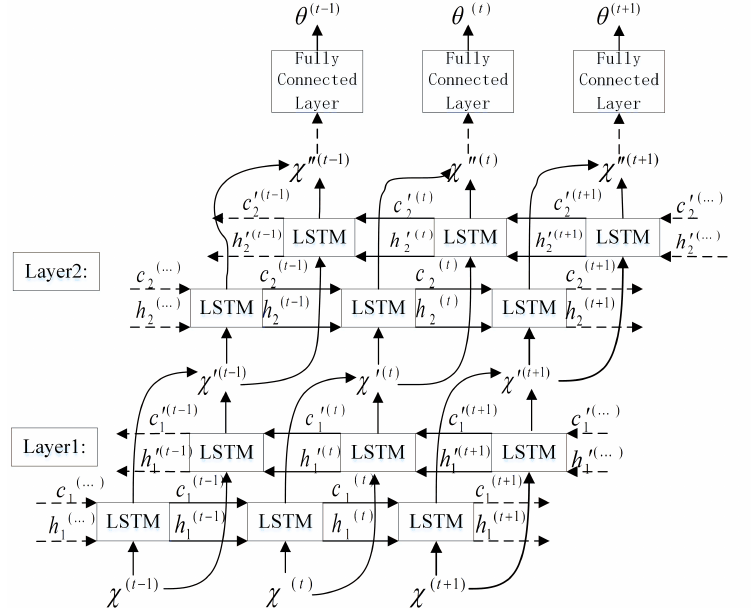
Figure 5. Bi-LSTM underwater acoustic separation network model